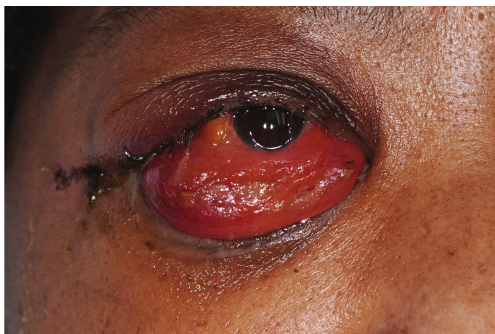
Figure 1: Initial presentation of the right ocular multiple myeloma.